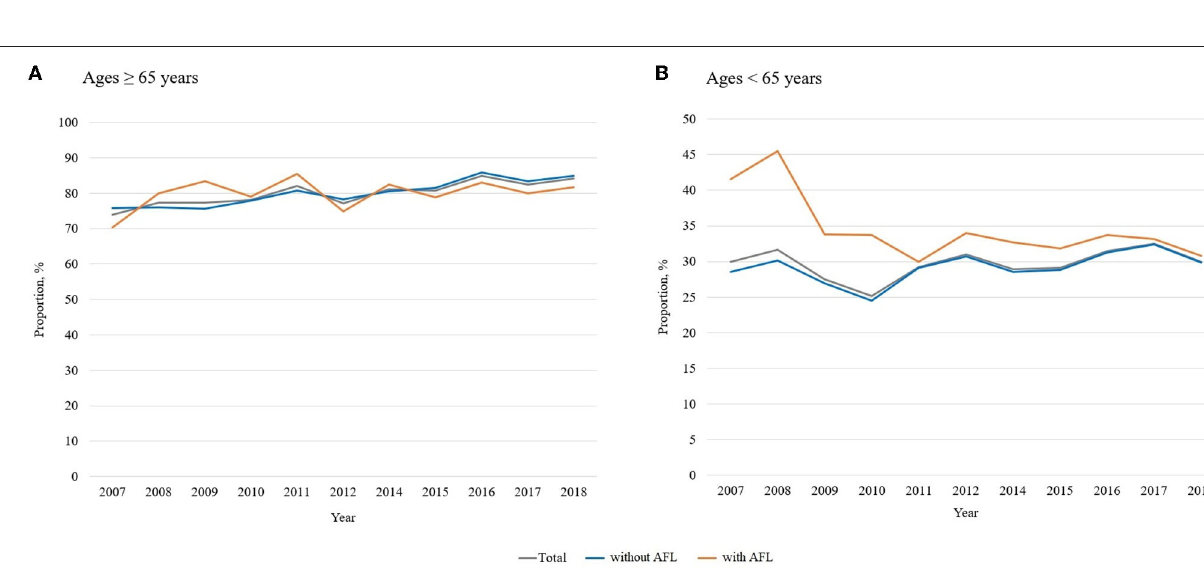
AFL Severity Influenza vaccination rate was further analyzed according to